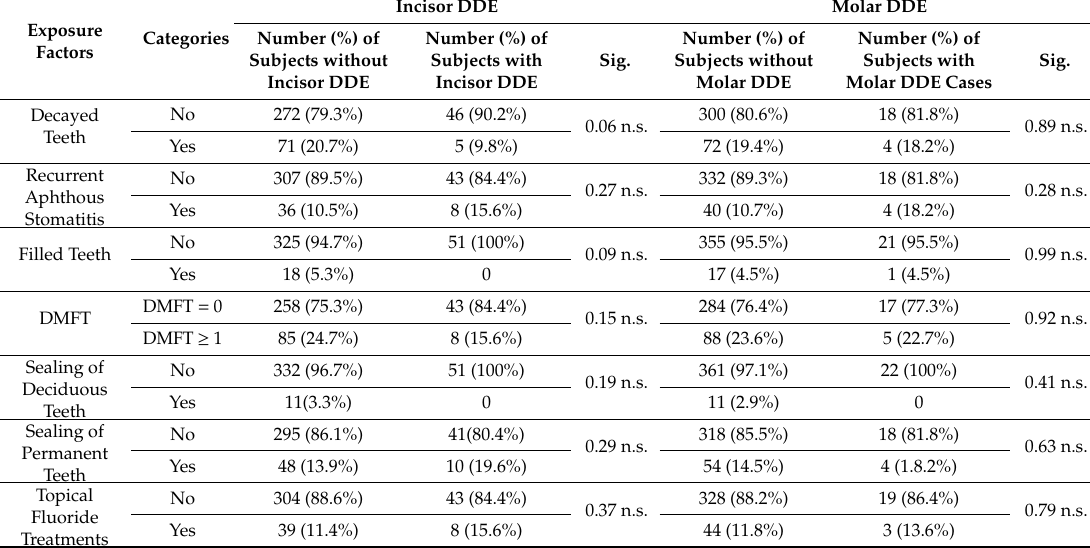
Table 2. Report of number of children (and percentage among cases and controls) for each exposure category with significant associations with developmental enamel defects (DDE).